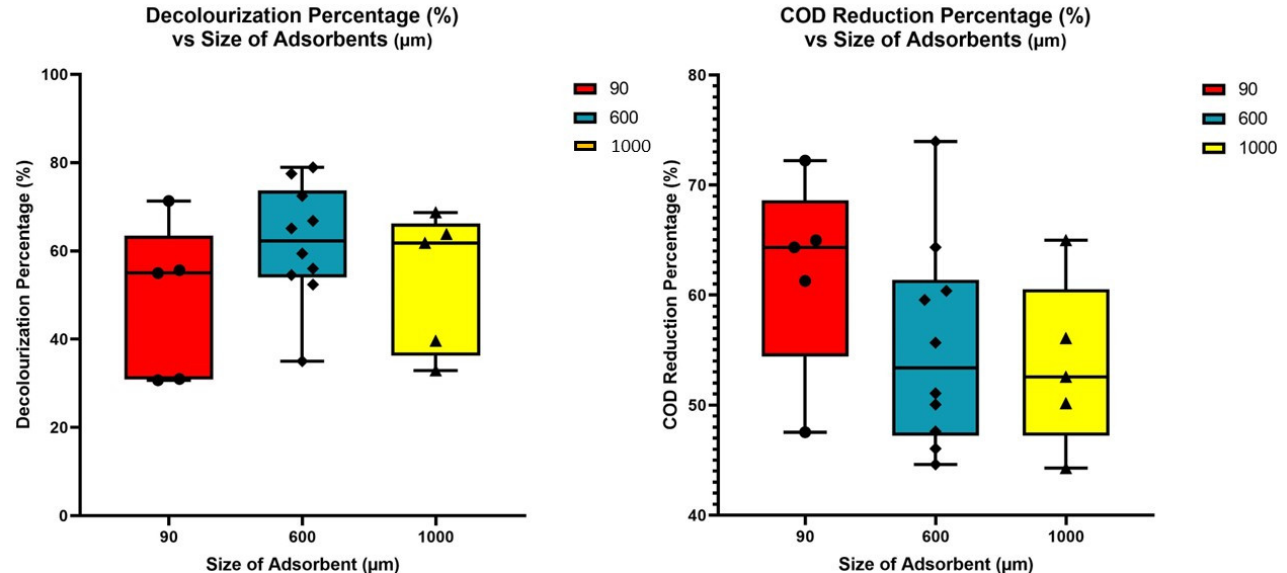
Figure 9. The decolourisation percentages ( left ) and COD reduction percentages ( right ) of STDW based on the size of adsorbents in μm.